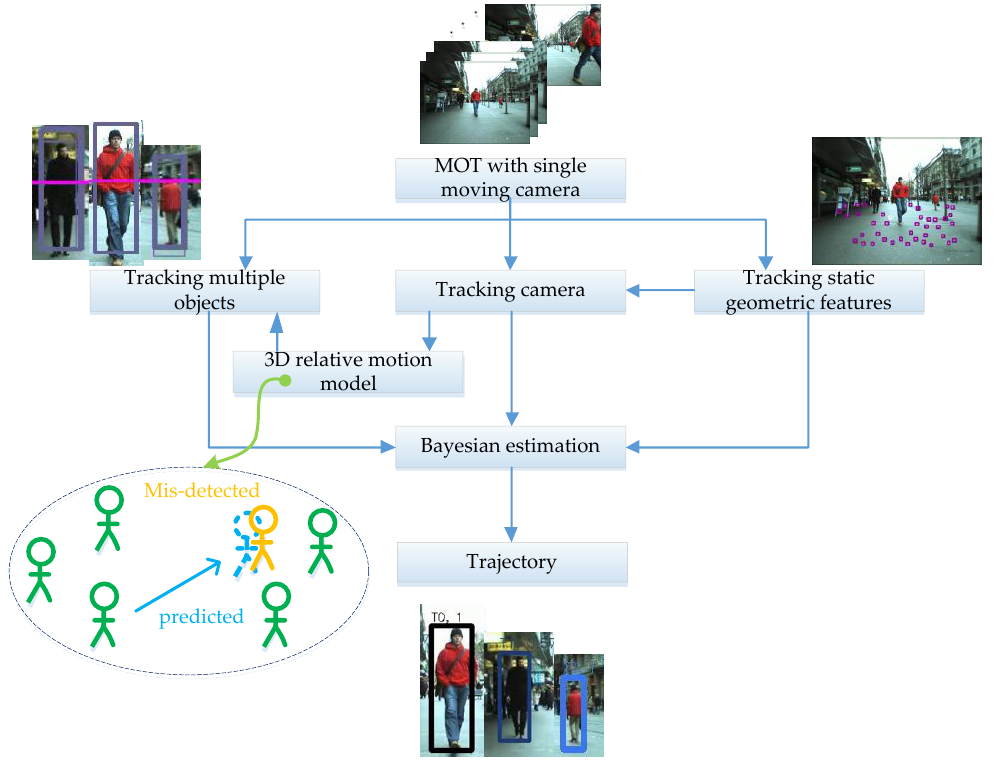
Figure 2. The scheme of the proposed method.